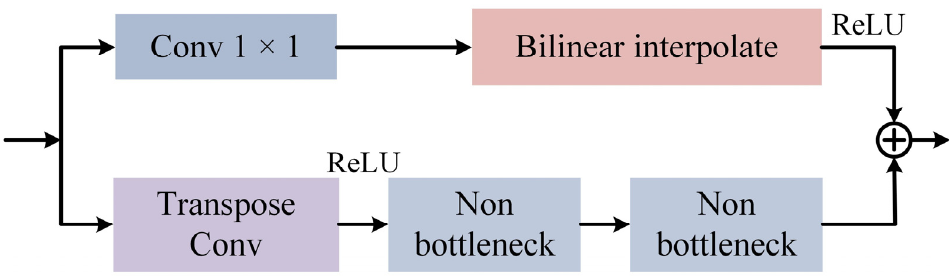
Figure 5. Bilateral Up-Sampling